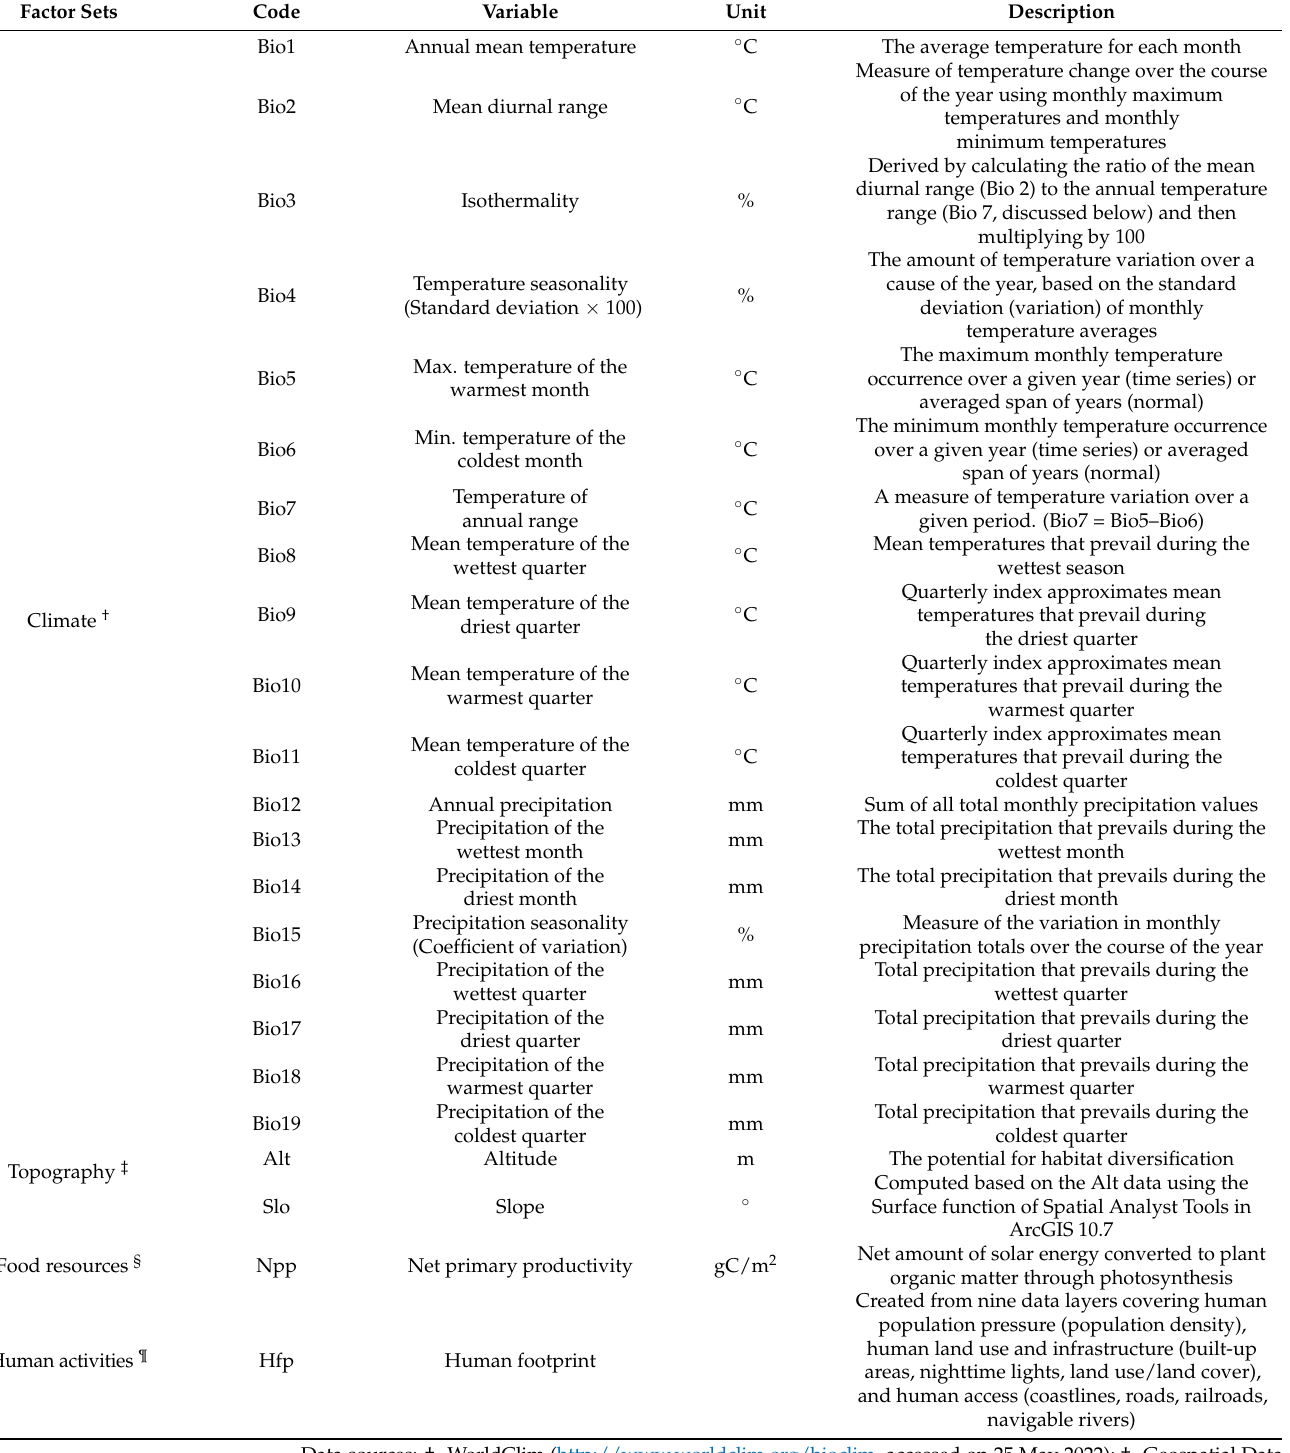
Table 1. List of environmental variables used for modeling the potential distribution of Gymnocypris chilianensis and Triplophysa hsutschouensis